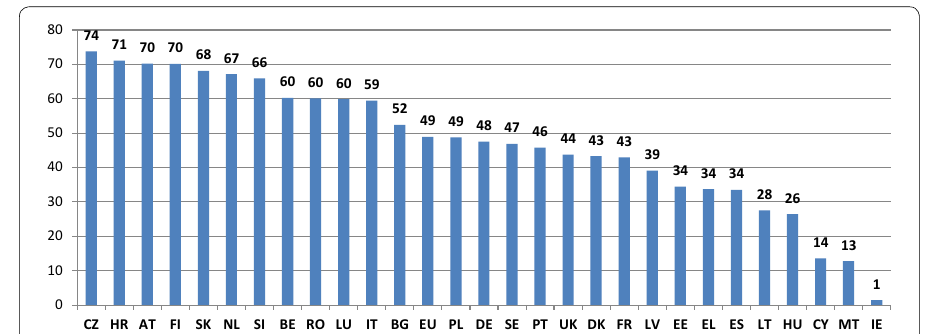
Fig. 1 Students enrolled in upper secondary vocational programmes (% of all upper secondary students), 2013 (Source: Authors’ calculations based on Eurostat, UOE data collection on education systems. Note: data on upper secondary programmes refer to level 3 of the ISCED 2011 classification. Data for NL are only based on students in public educational institutions. EU averages are weighted